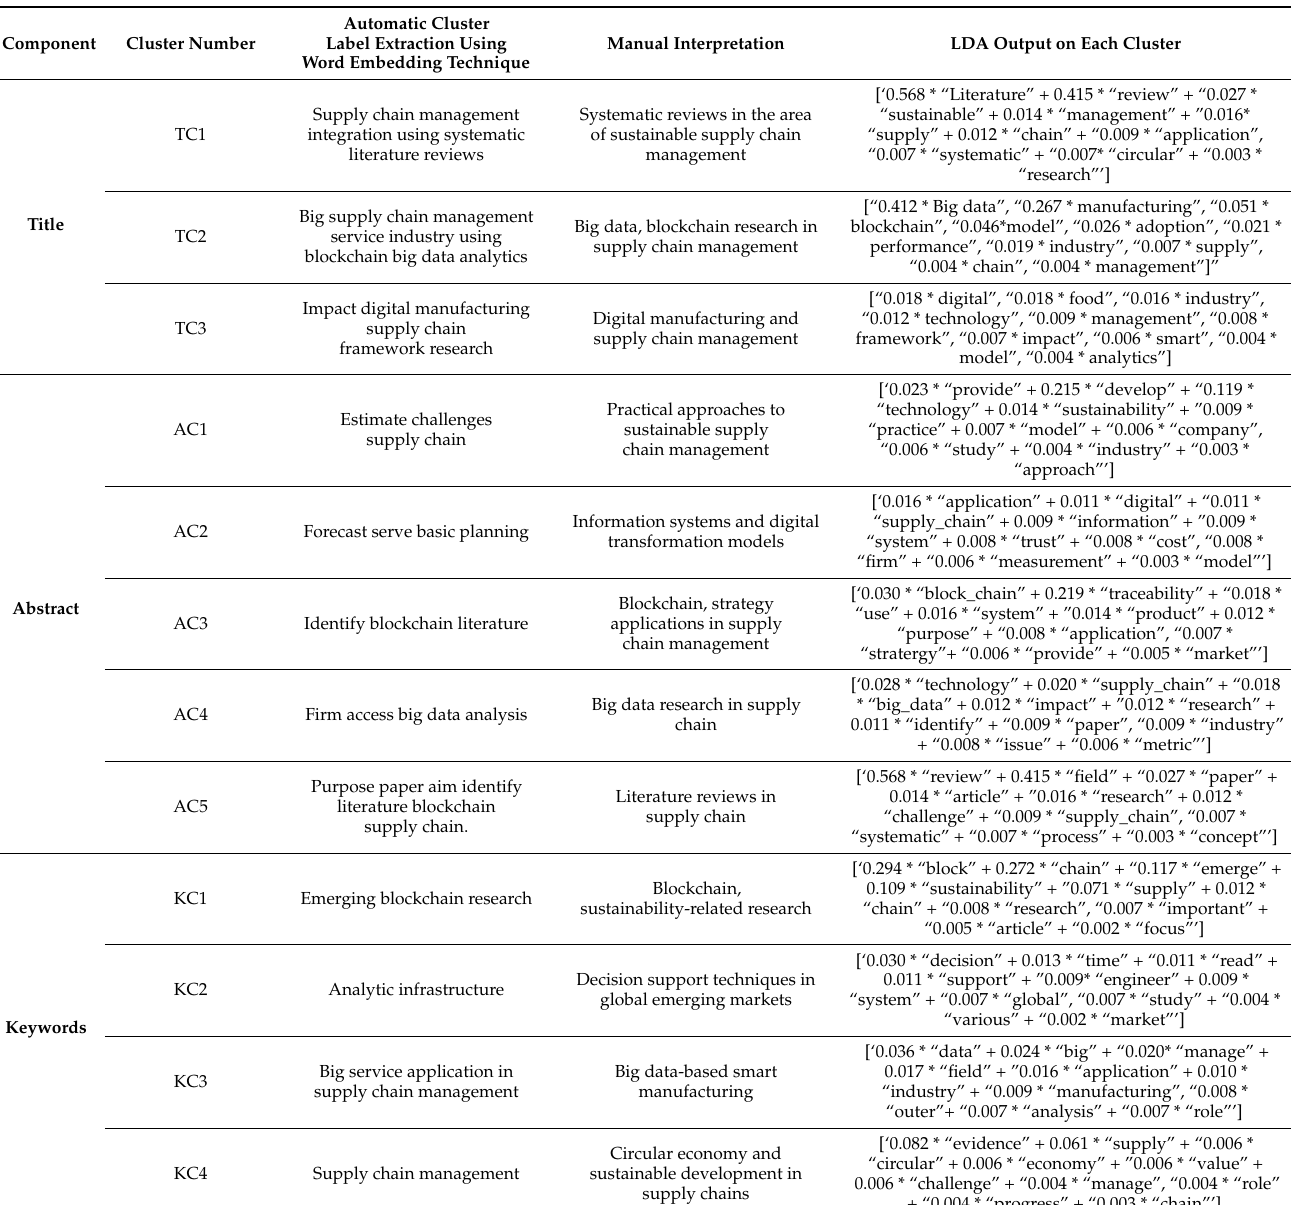
Table 2. Topic modeling and cluster analyzing using topic modeling technique (LDA), word embed- ding